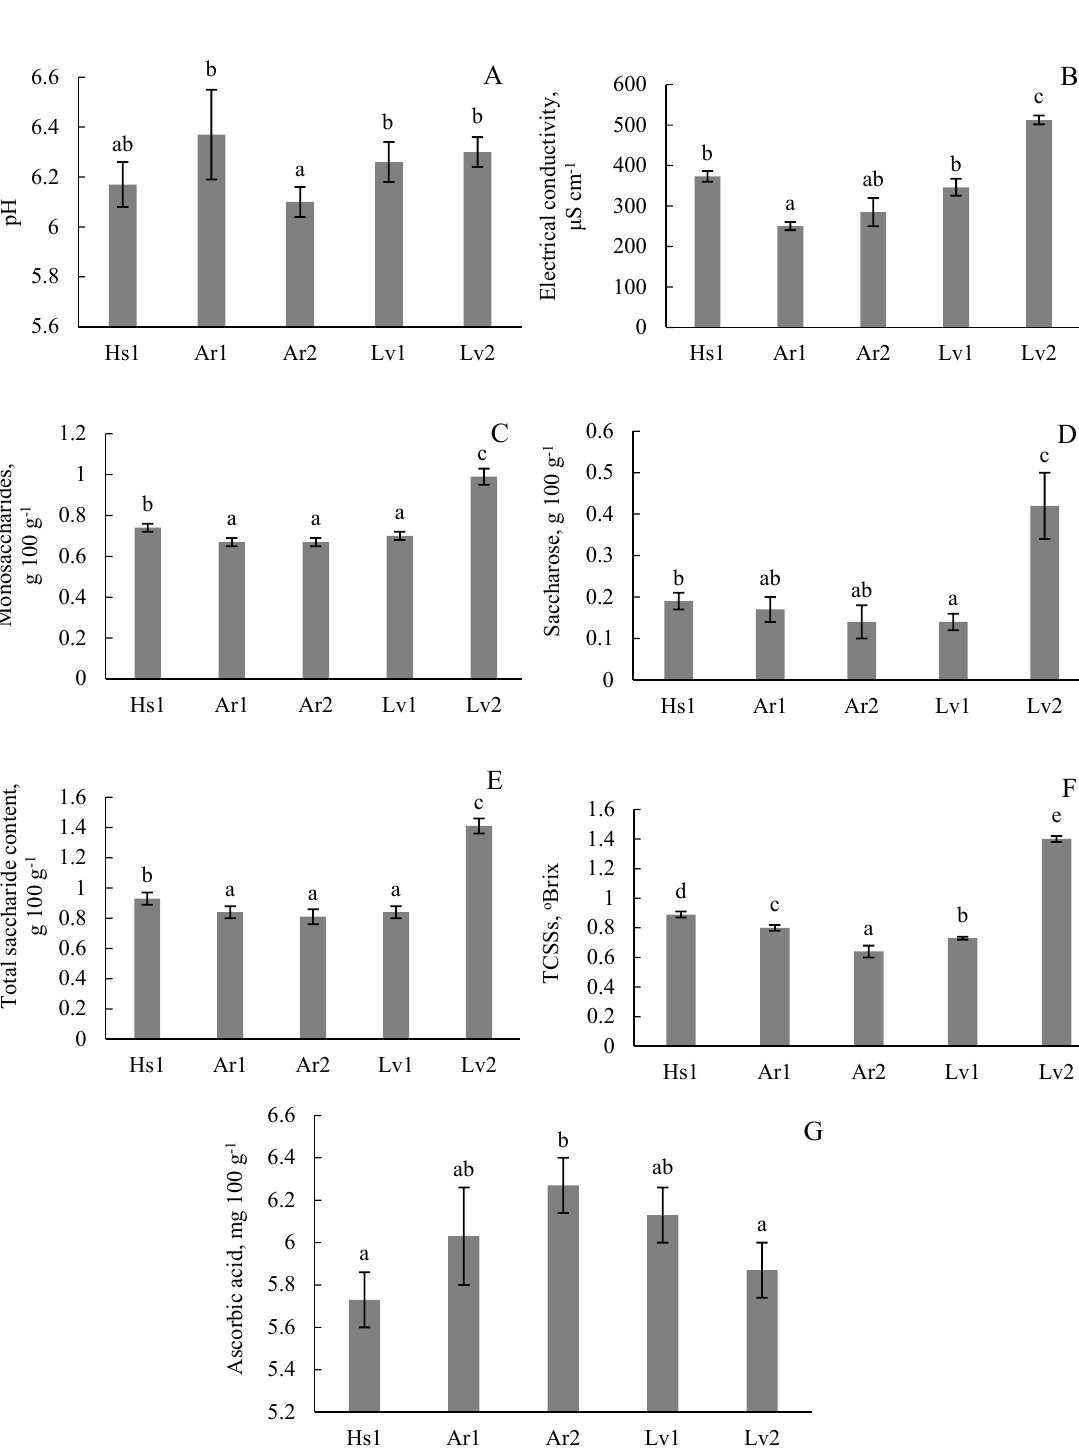
Figure 5. Mean pH value ( A ), electrical conductivity ( B ) and mean concentrations of monosaccharides ( C ), saccharose ( D ), total saccharide content ( E ), total content of soluble solids (TCSSs) ( F ) and ascorbic acid ( G ) in the birch sap of silver birch ( Betula pendula ) trees (in total, n = 103) growing in di ff erent soils. The results are expressed as the mean ± SE, and the di ff erent lowercase letters indicate significantly di ff erent ( p < 0.05) means based on Tukey’s test.